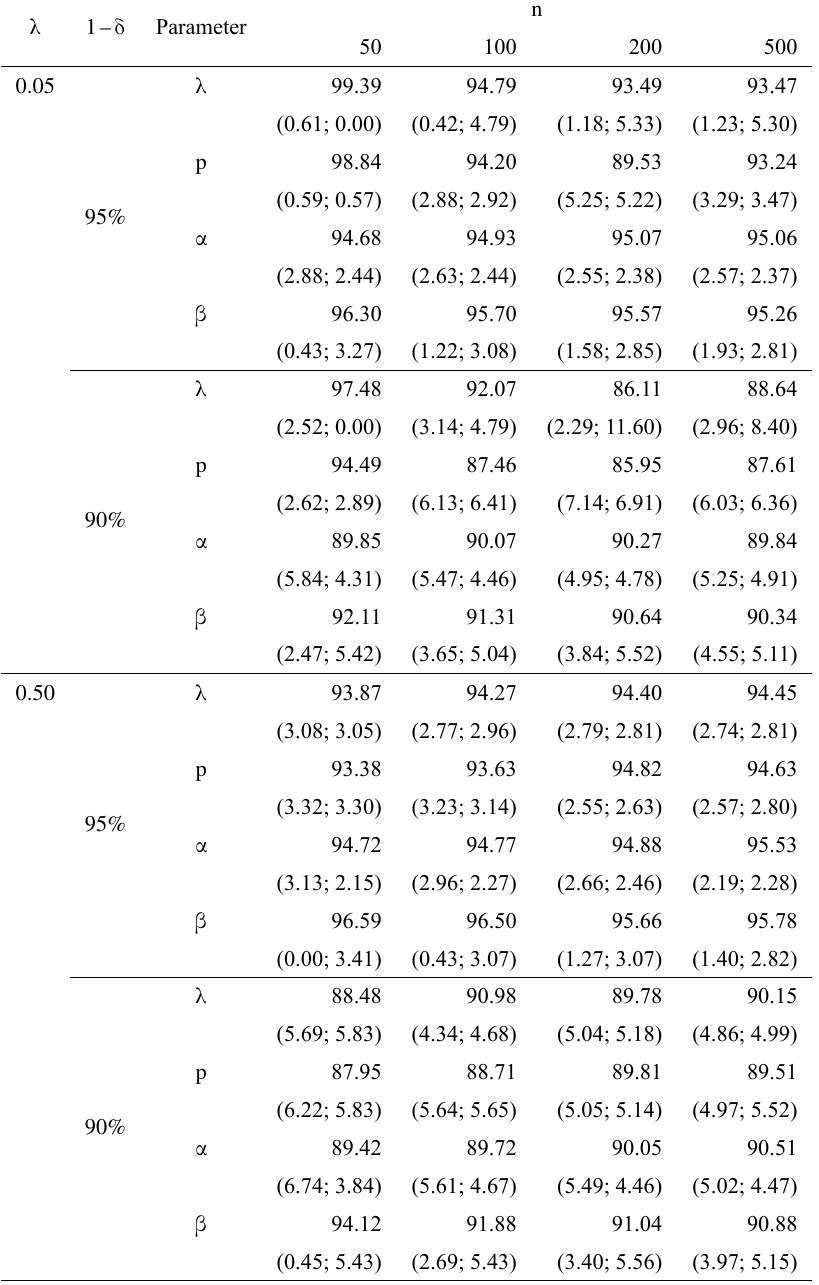
Confidence intervals empirical coverages and noncoverages (to the left; to the right) rates (%), ZOIK distribution; p = 0.5, α = 1.5p = 0.5, α = 1.5p = 0.5, α = 1.5 and β = 3.0 β = 3.0 β = 3.0